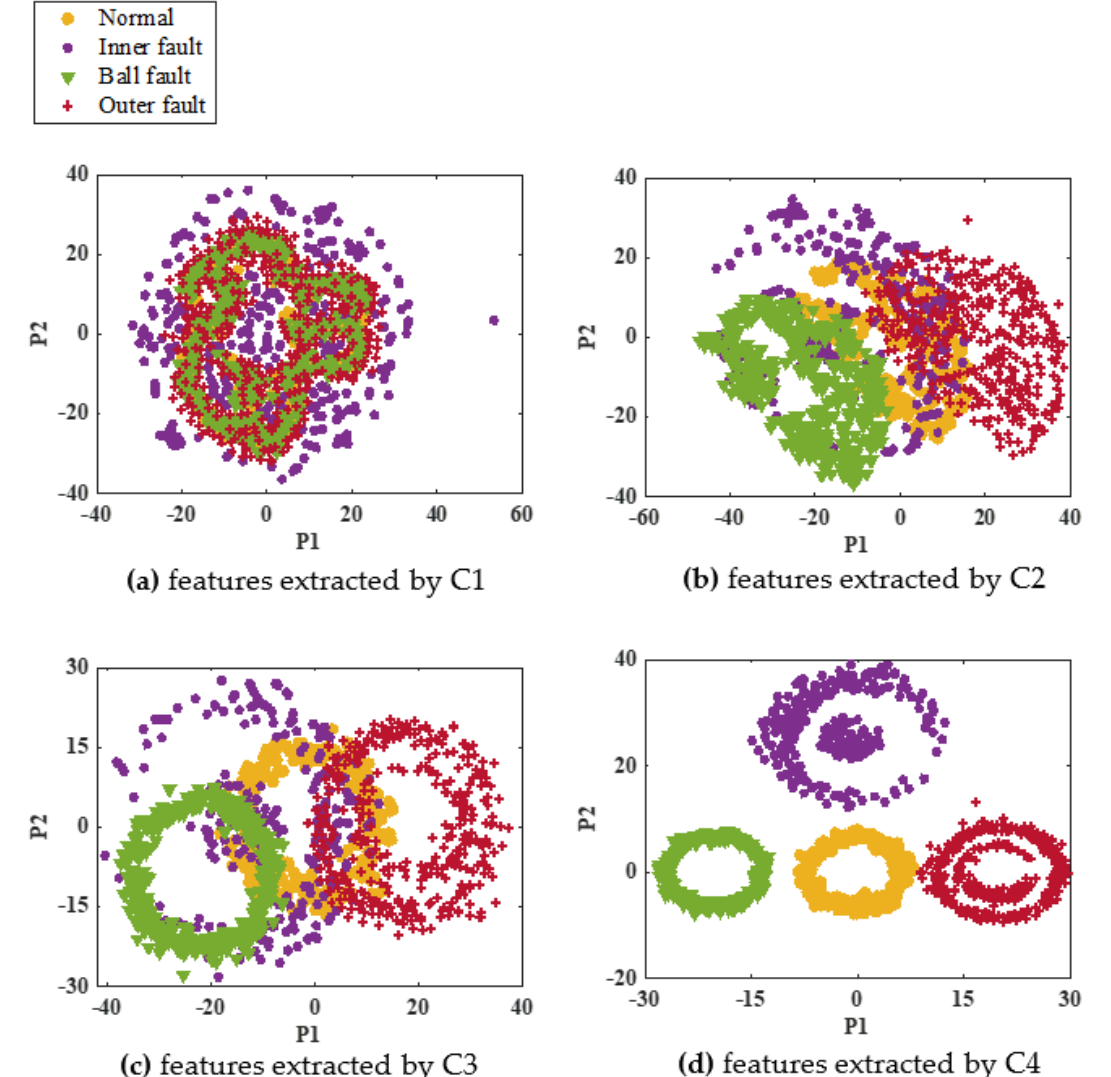
Figure 6. Features scatter diagram based on the proposed